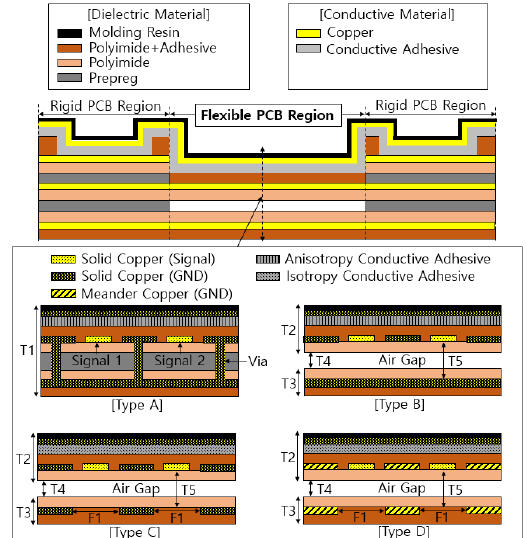
Figure 8. Side view of the rigid-flex structure and cross-section views of the four FPCB structures.